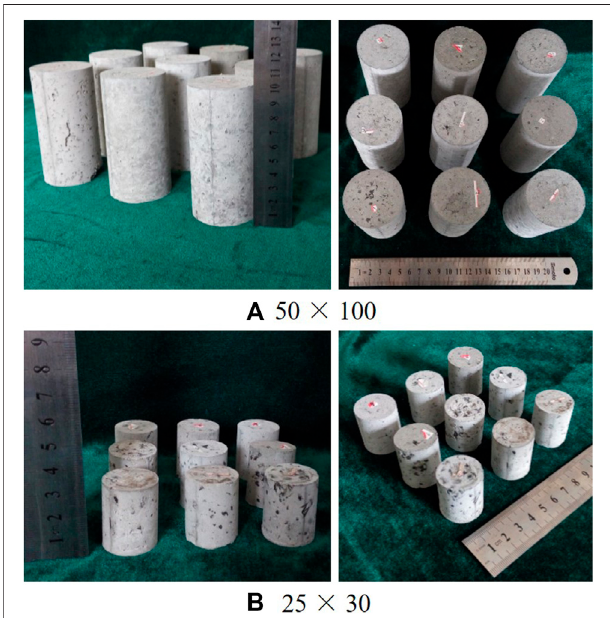
FIGURE3| 9consolidationofcoalunderdifferenttestconditions. (A) 50 × 100, (B) 25